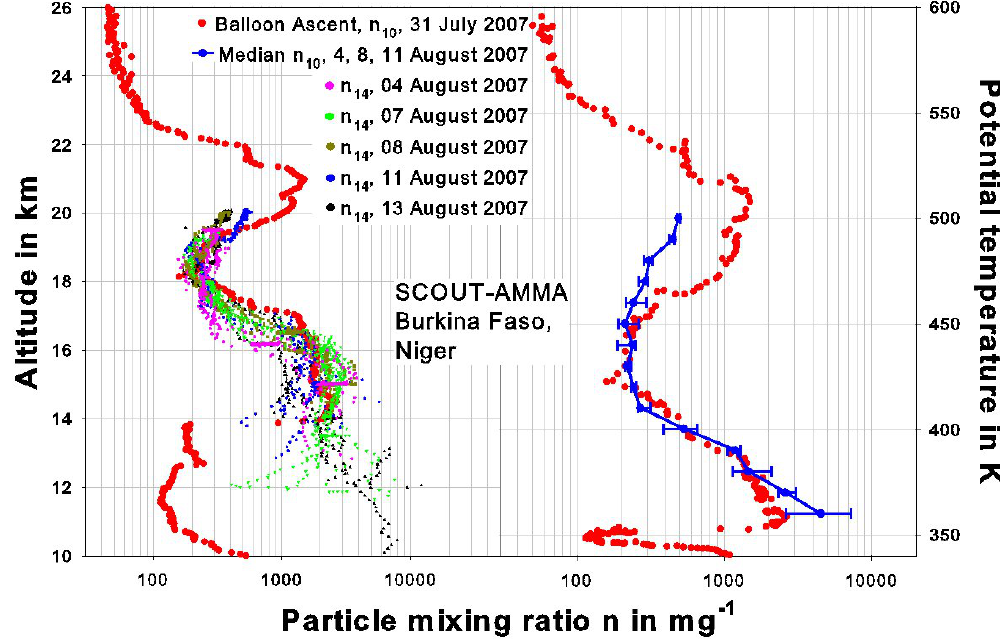
Fig. 10. Intercomparison of the individual n 10 particle mixing ratio measurements of the balloon launch on 31 July 2006 from Niamey, Niger, with the n 14 data of all local M-55 “Geophysica” flights from Ouagadougou (Burkina Faso). The COPAS data points in the left panel represent 15s averages while the balloon data (larger red points) are averaged over 5s. In the right panel the same data are displayed as function of potential temperature with the blue points designating the median (with 25% and 75% percentiles) from 10K altitude bins (note: The left and right ordinates do not correspond to each